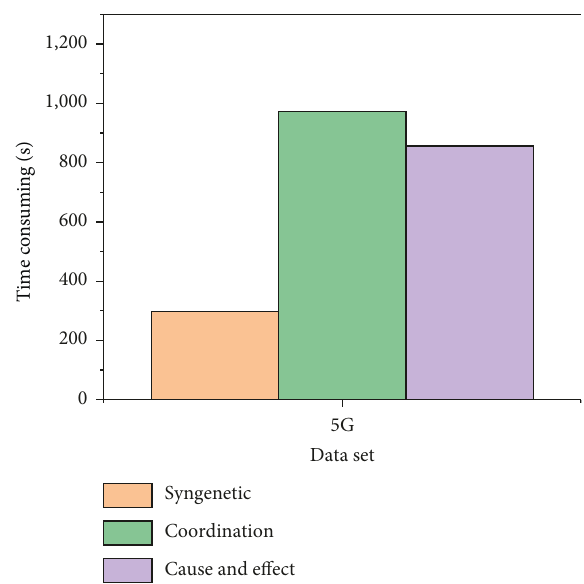
Figure 6: The time consumption of different patterns in 5G dataset.